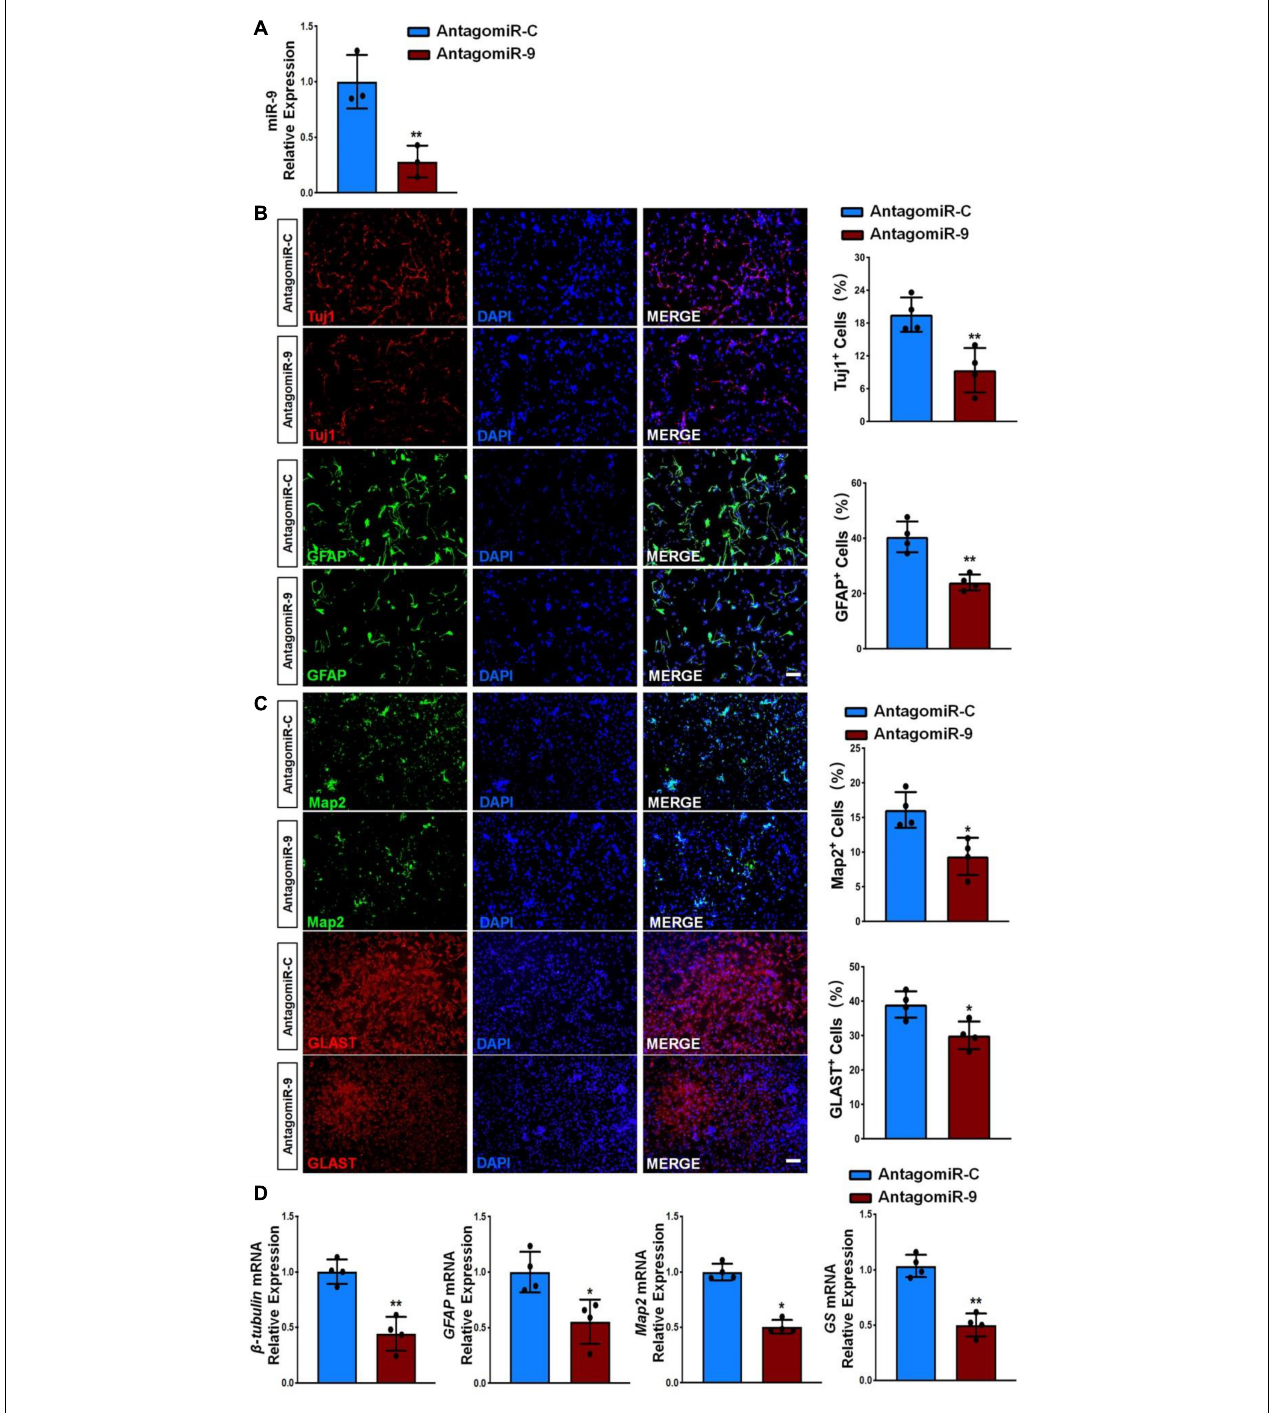
FIGURE 4 | miR-9 loss-of-function inhibits NSC differentiation. (A) NSCs transfected with either antogomiR-C or antogomiR-9 were cultured for 6 days in differentiation conditions. The transfection efficiency was determined by quantifying the intracellular miR-9 expression levels via RT-qPCR analysis. (B) Representative images of pre-mature cell markers (Tuj1 and GFAP) staining were shown. Proportions of cells exhibiting immunoreactivities of pre-mature cell markers (Tuj1 + and GFAP + ) were determined (in the right panel). (C) Representative images of matured cell markers (Map2 and Glast) staining were shown. Proportions of cells exhibiting immunoreactivities of pre-mature cell markers (Map2 + and Glast + ) were determined (in the right panel). (D) The expression levels of transcripts corresponding to pre-mature cell markers ( β III-tubulin and GFAP ) and matured cell markers ( Map2 and GS ) was determined by RT-qPCR analysis. Data were represented as mean ± SE from three independent experiments. * and ** denote p < 0.05 and p < 0.01, respectively. Scale bar 100 µ m in panel (B,C) .